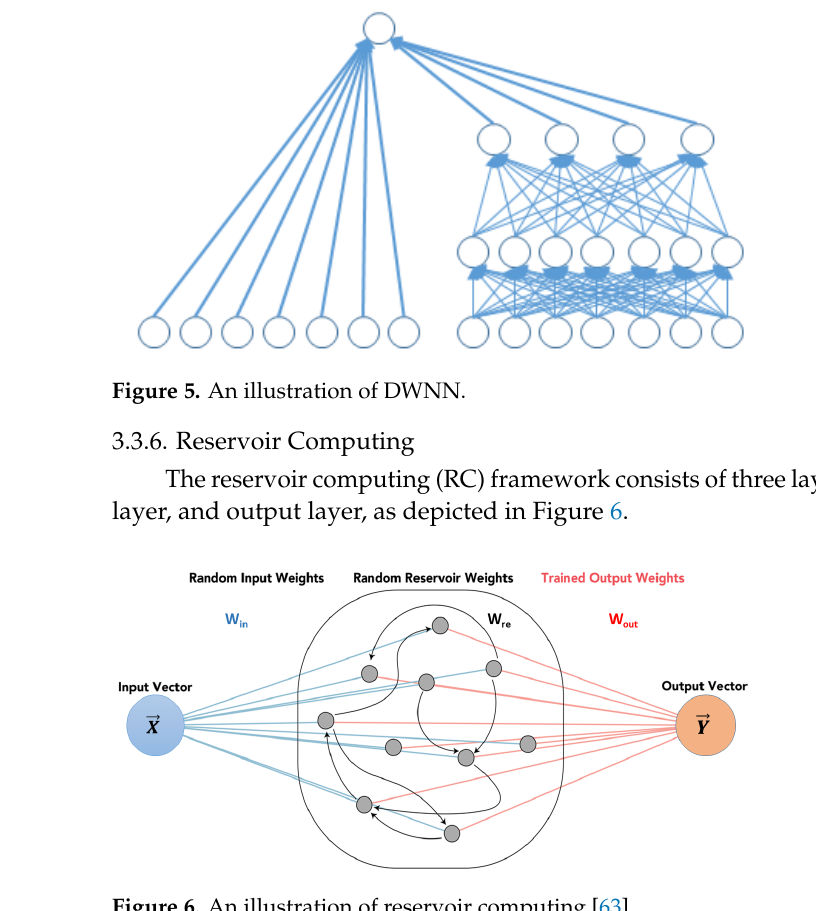
Figure 6. An illustration of reservoir computing